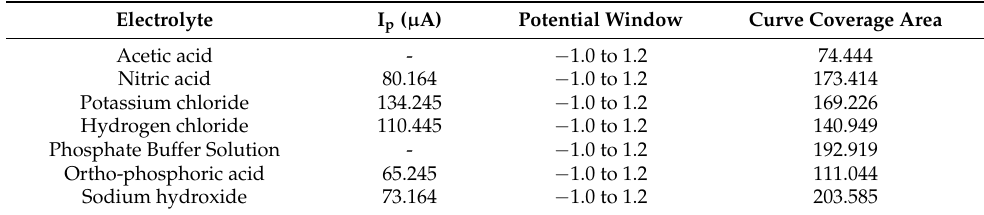
Table 3. Peak properties of the investigated